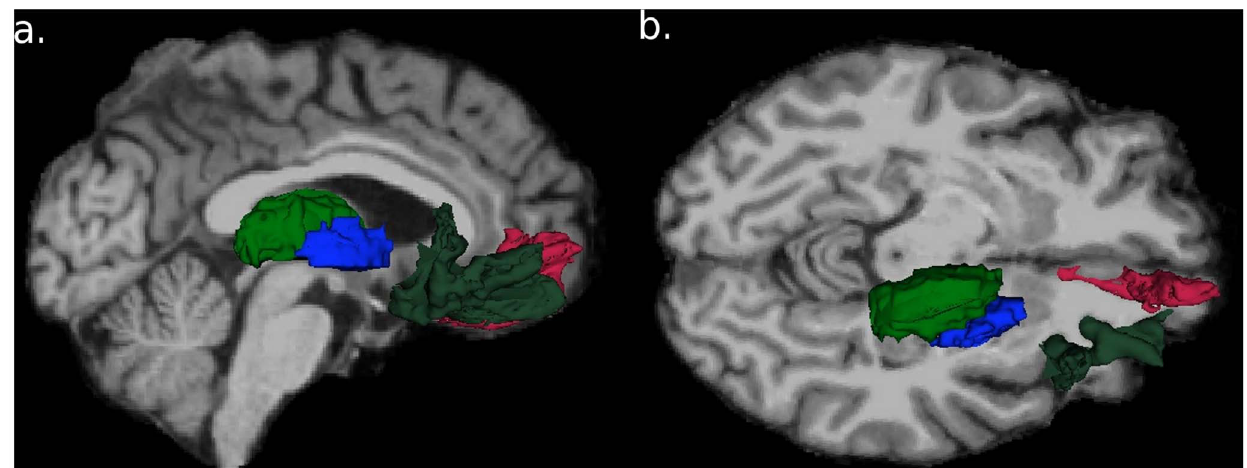
Figure 2. Free Surfer regions of interest. Free Surfer maps of ROI used for this analysis. A) Sagittal (top) B) Axial (bottom) view of Freesurfer ROIs. Blue: globus pallidum, Green: caudate, Dark Green: lateral prefrontal cortex, Magenta: medial prefrontal cortex.